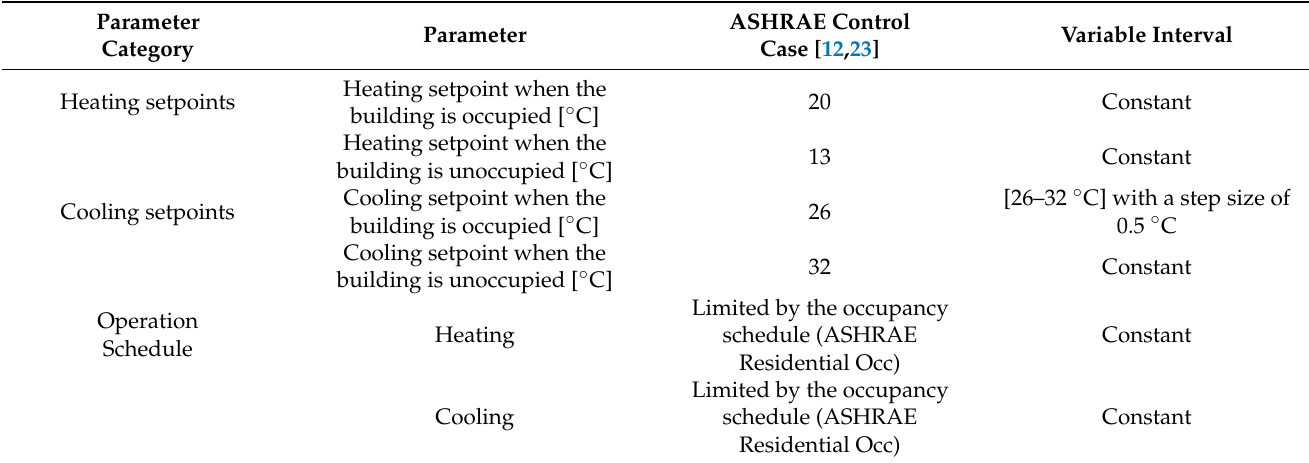
Table 1. HVAC control parameters.